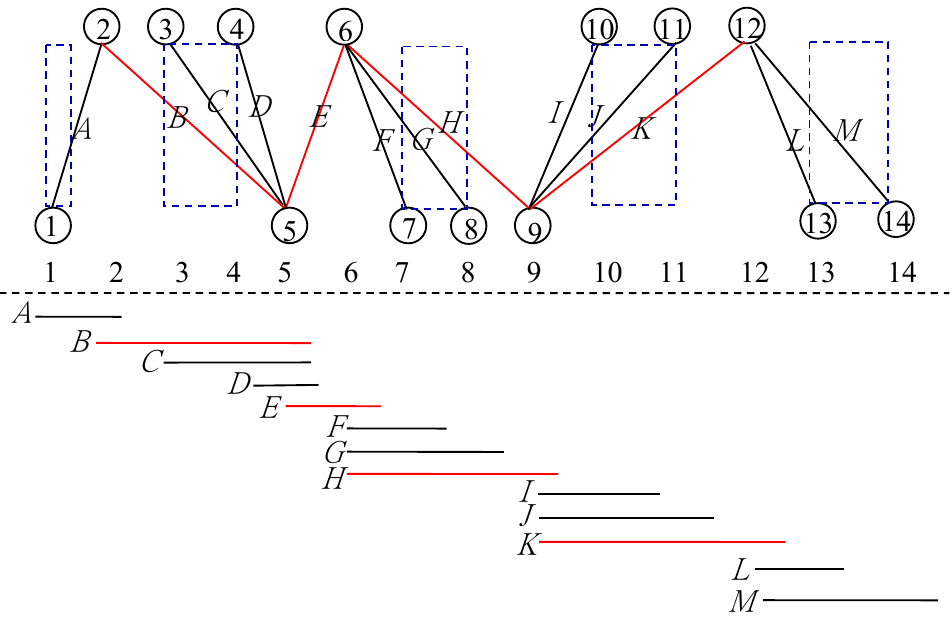
Figure 9. A redistribution graph G with the intervals of L ( G ).